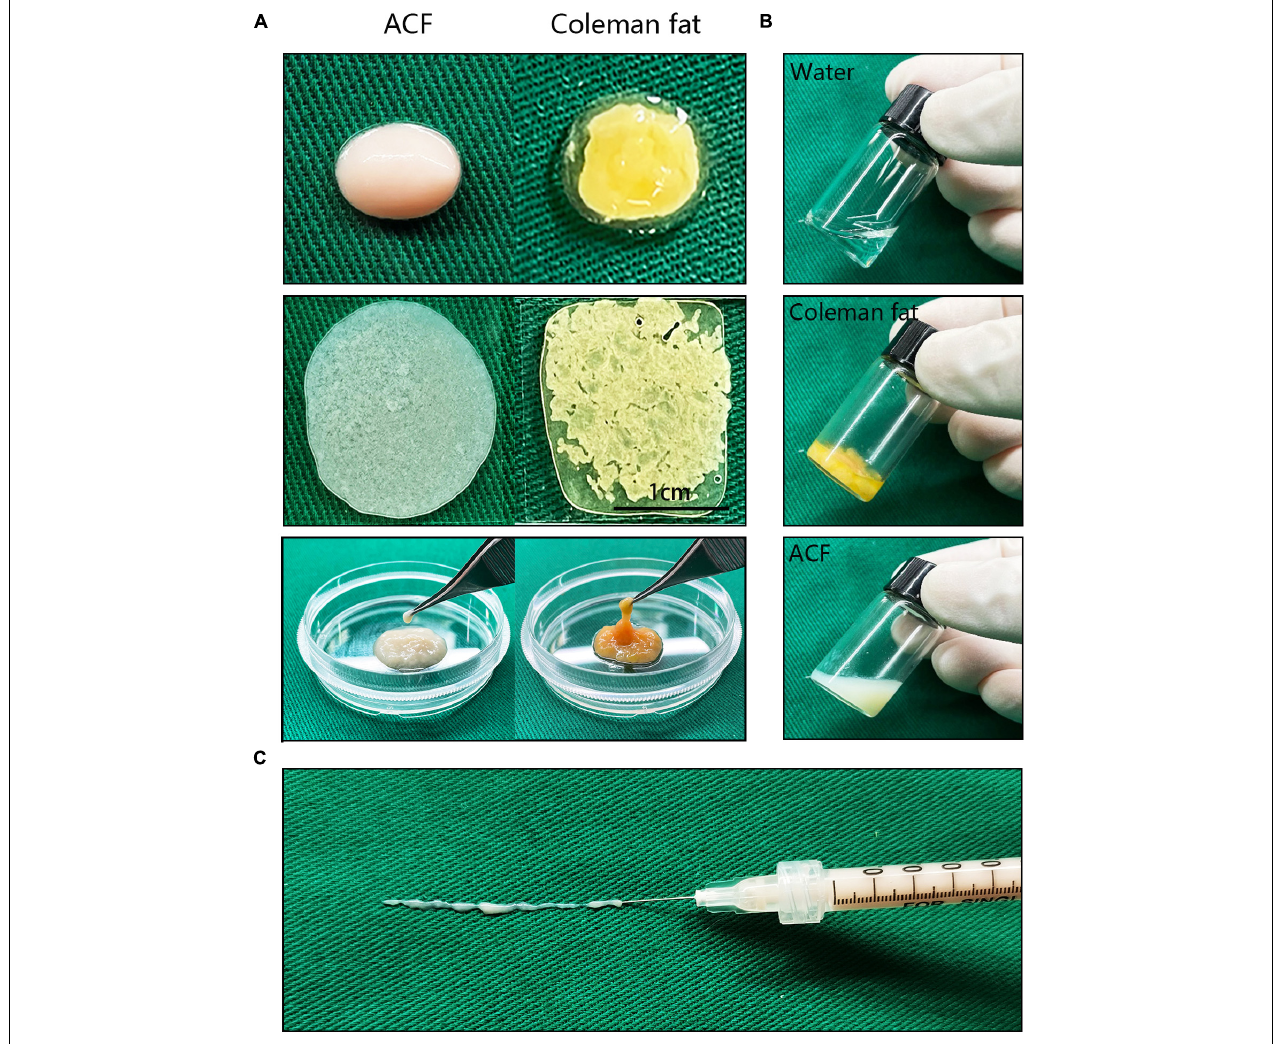
FIGURE 2 | Macroscopic observation and injectability of ACF. (A) Macroscopic observation of Coleman fat and ACF. ACF is a pinkish-white, homogeneous, and viscous substance with a smooth texture. Scale bar = 1 cm. (B) ACF is a viscous semifluid. Coleman fat can hardly tilt, the water can tilt immediately, and ACF can tilt completely after 54.72 ± 0.23 s. (C) ACF could be injected through 31-gauge sharp